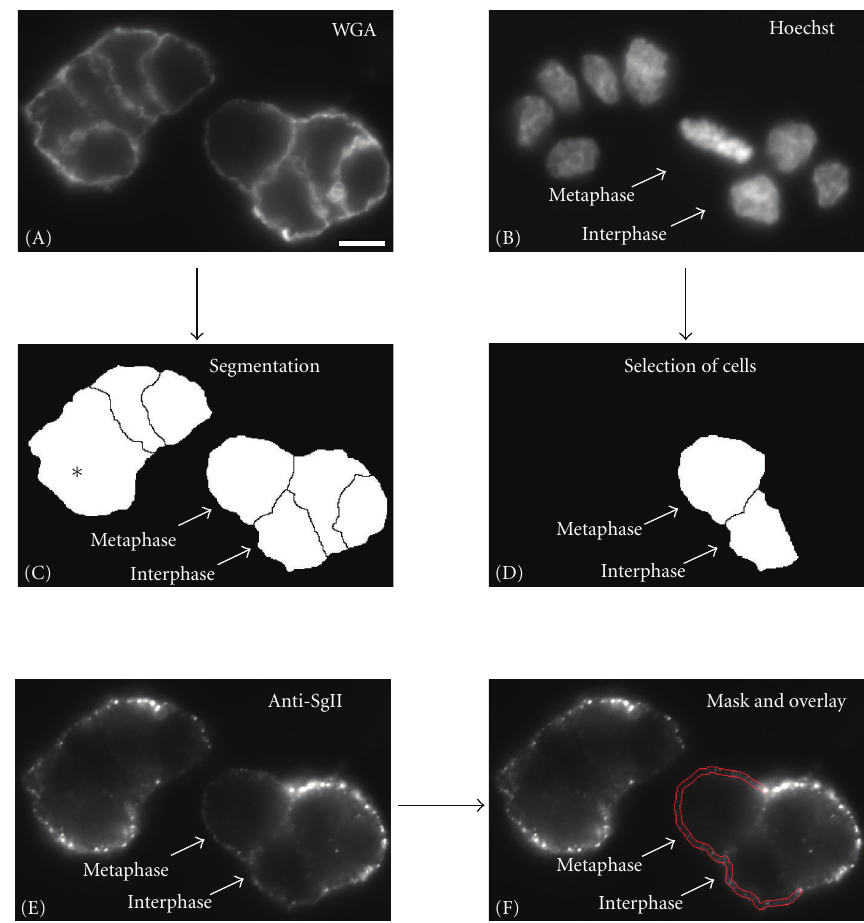
Figure 10: Quantification and comparison of the intensity of SgII surface staining of interphase and metaphase cells. PC12 cells were stained with WGA (A), Hoechst (B) and by immunocytochemistry for surface-associated SgII (E). Images displaying the WGA stain were used for segmentation (C). Asterisk in (C) indicates cell borders that are not detected. The Hoechst stain was used for the identification of metaphase and interphase cells (B). A mask was constructed for the quantification of the surface-associated SgII signal (red double-line in (F)) delineating the PM of PC12 cells located at the outside of the cell cluster. For more details please see Materials and Methods. Scale bar, 10 μ